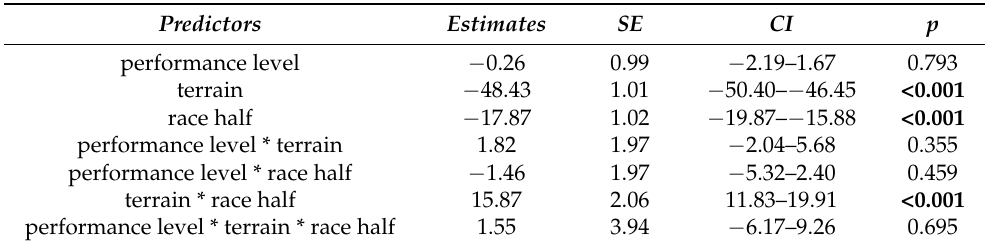
Table 2. Linear mixed effect model output for the top 10 men; significant results are highlighted in bold.